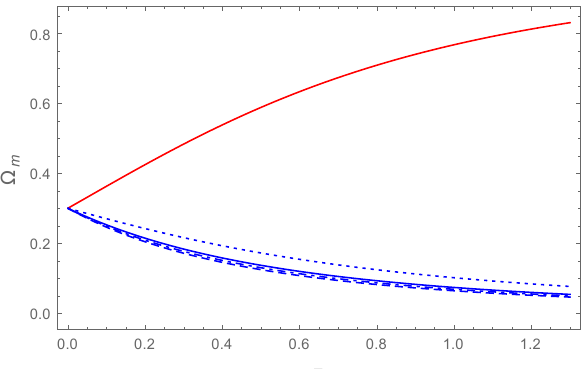
(cid:0) (cid:1) Tg µν − T µν with